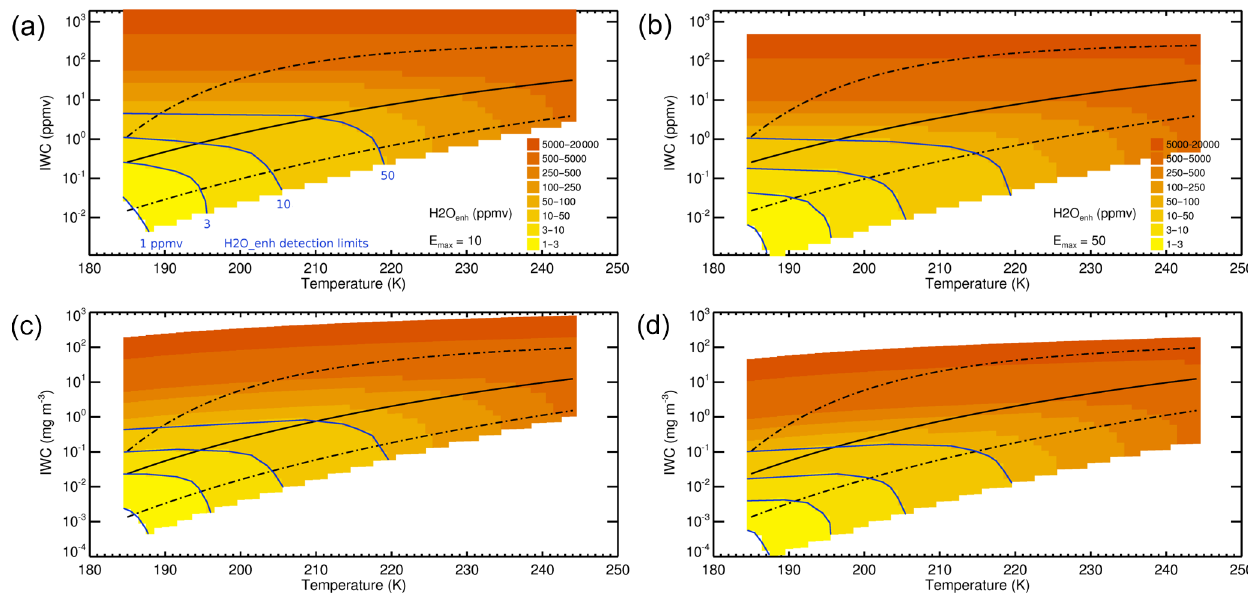
Figure 3. Relation between H 2 O enh and IWC regarding temperature for given H 2 O gas (assumed as water vapor saturation value), calculated (cid:16) (cid:17) H 2 O enh − H 2 O gas from Eq. (1) IWC = for two different E max ( a, c : 10, b, d : 50; a, b volume mixing ratio, c, d concentration). The minimum E max difference between H 2 O enh and H 2 O gas to detect IWC is 5% to account for measurement uncertainties, i.e. in the white region below the calculated IWCs, H 2 O enh / H 2 O gas < 1.05. Blue lines: H 2 O enh isolines corresponding to the detection limit of an instrument, the 1, 3 and 10ppmv H 2 O enh isolines represent the IWC detection limit of the FISH, HAI and WARAN instruments described in Sect. 4.1.2. Black solid and dashed lines: medium, core max and min IWCs after Schiller et al.